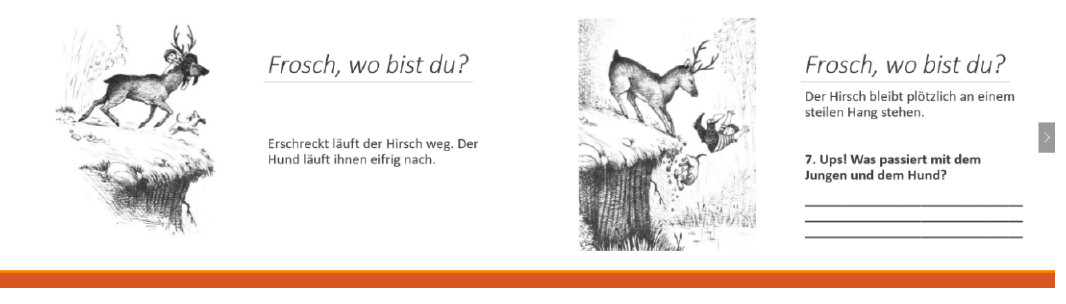
Figure A9. Pretest: Production task.